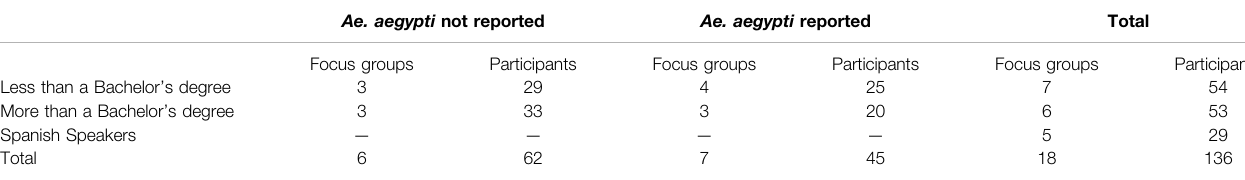
TABLE 2 | Number of focus groups and participants in recruitment